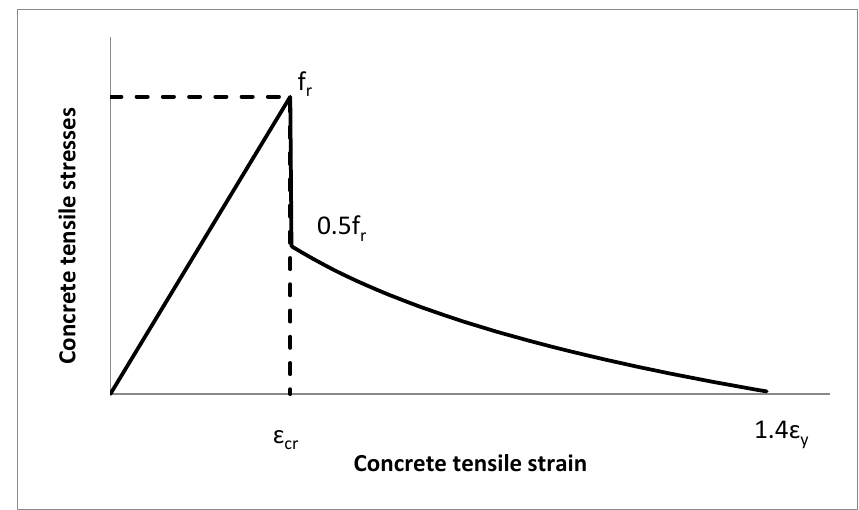
Figure 7. Suggested concrete constitutive tensile model. Table 2. The geometrical parameters for the tested beams.